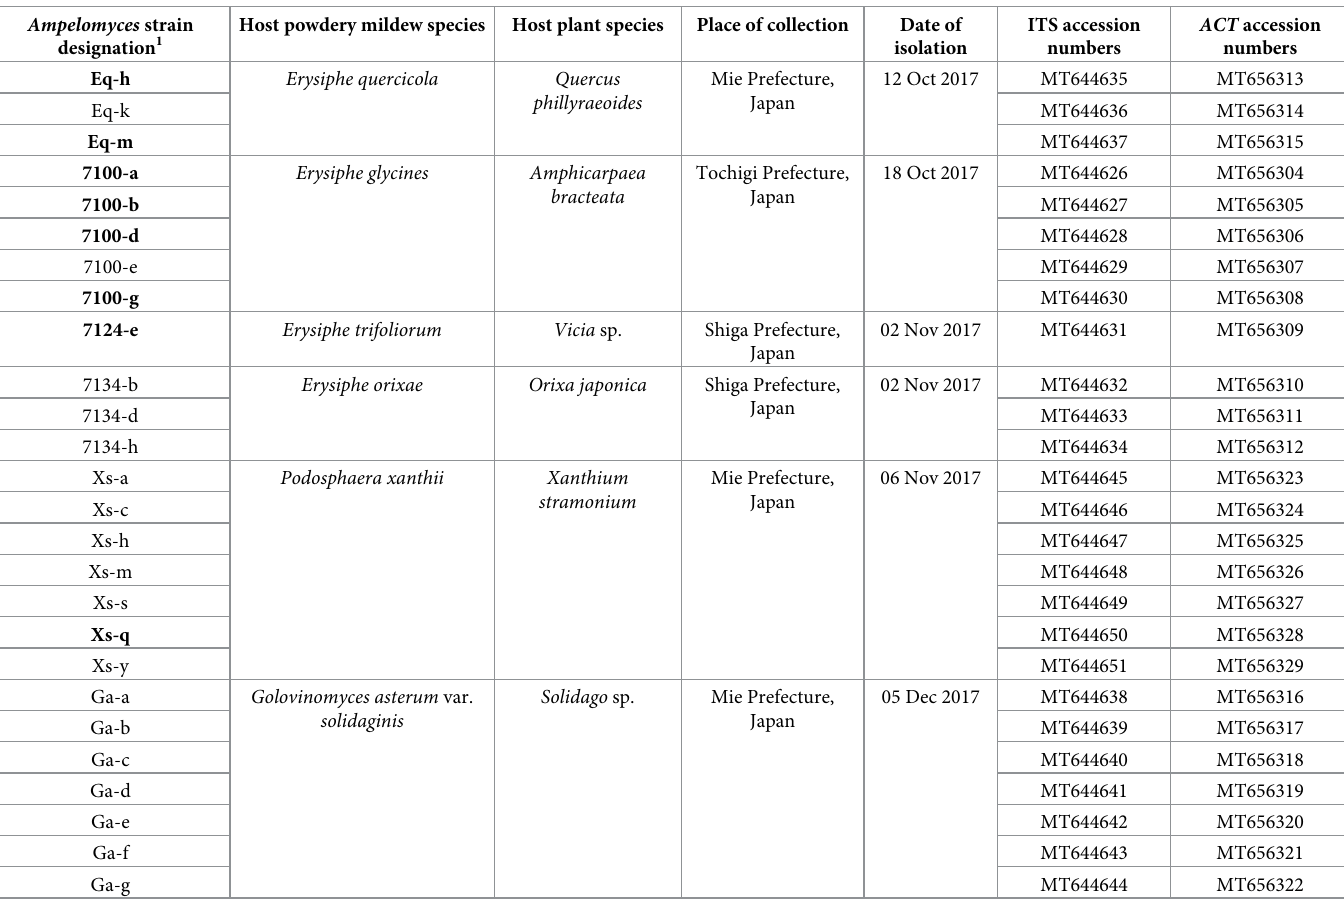
Table 1. Designations, hosts, isolation data and GenBank accession numbers of the rDNA-ITS and ACT sequences of the 26 Ampelomyces strains included in the current